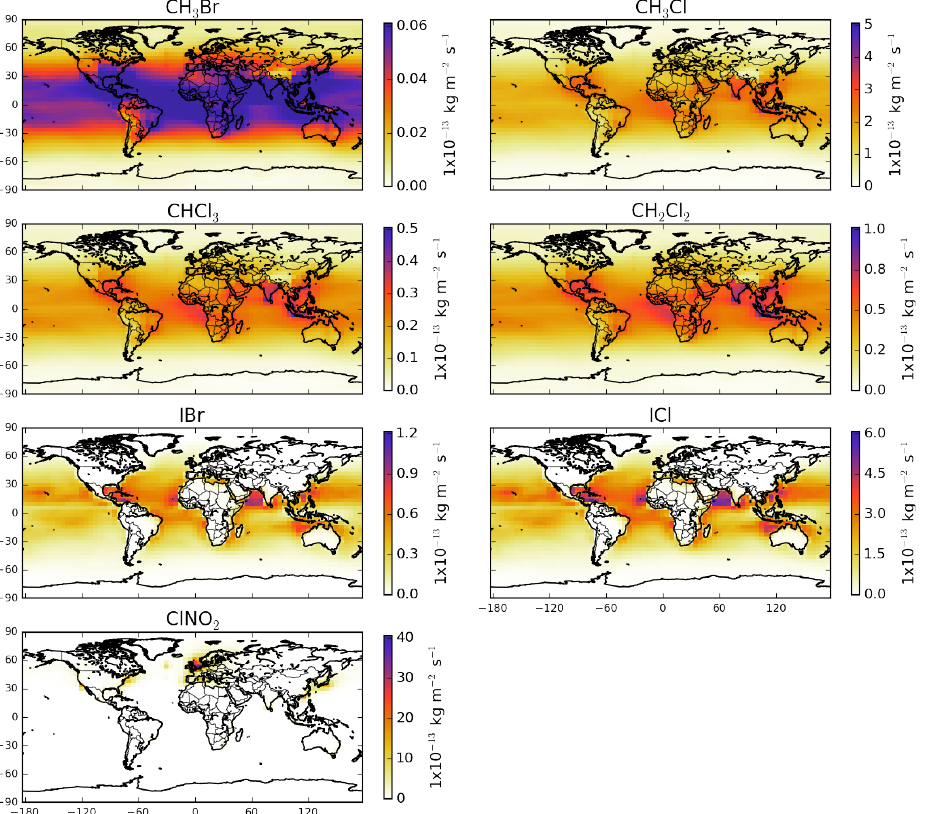
Figure 1. Average annual halogen surface emission of species and column-integrated fluxes for species that have fixed surface concentrations in the model (CH 3 Cl, CH 3 Cl 2 , CHCl 3 , CHBr 3 ) or those with vertically variable sources (ClNO 2 from N 2 O 5 uptake on sea-salt and I X ( X = Cl, Br) production from HOI, lNO 2 , and lNO 3 uptake). Values are given in kg X m − 2 s − 1 ( X = Cl, Br, I).